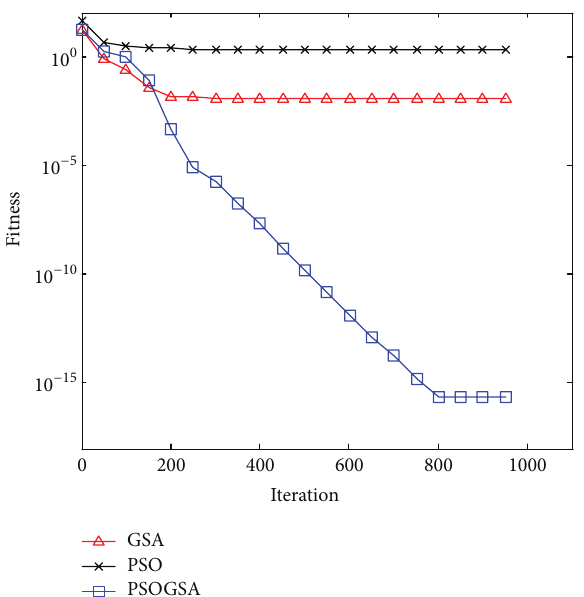
Figure 3: Testing results of Rastrigin function.